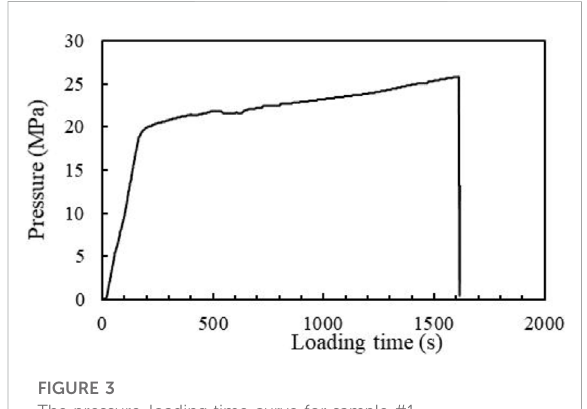
FIGURE 3 The pressure-loading time curve for sample #1.